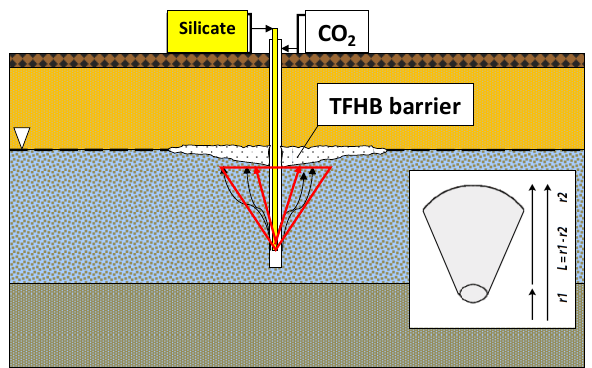
Figure 6. Domain of the 1-D transport and reaction model.